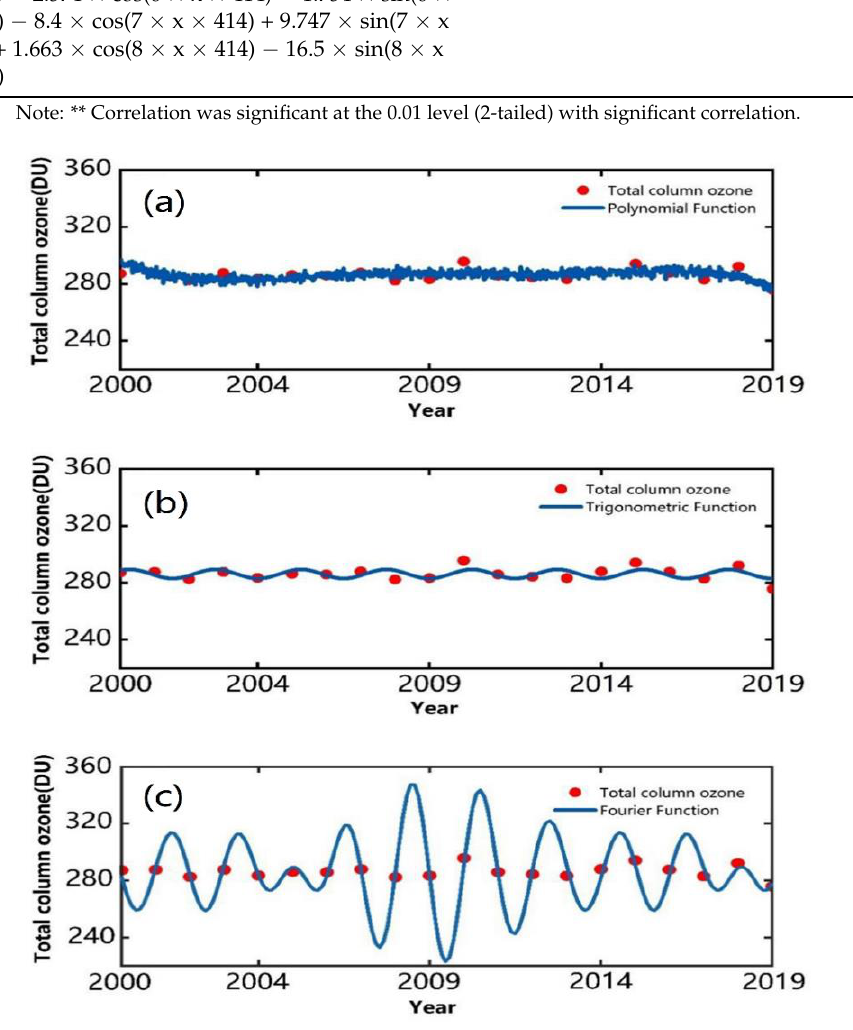
Table 4. The accuracy analysis of the results by different fitting functions.